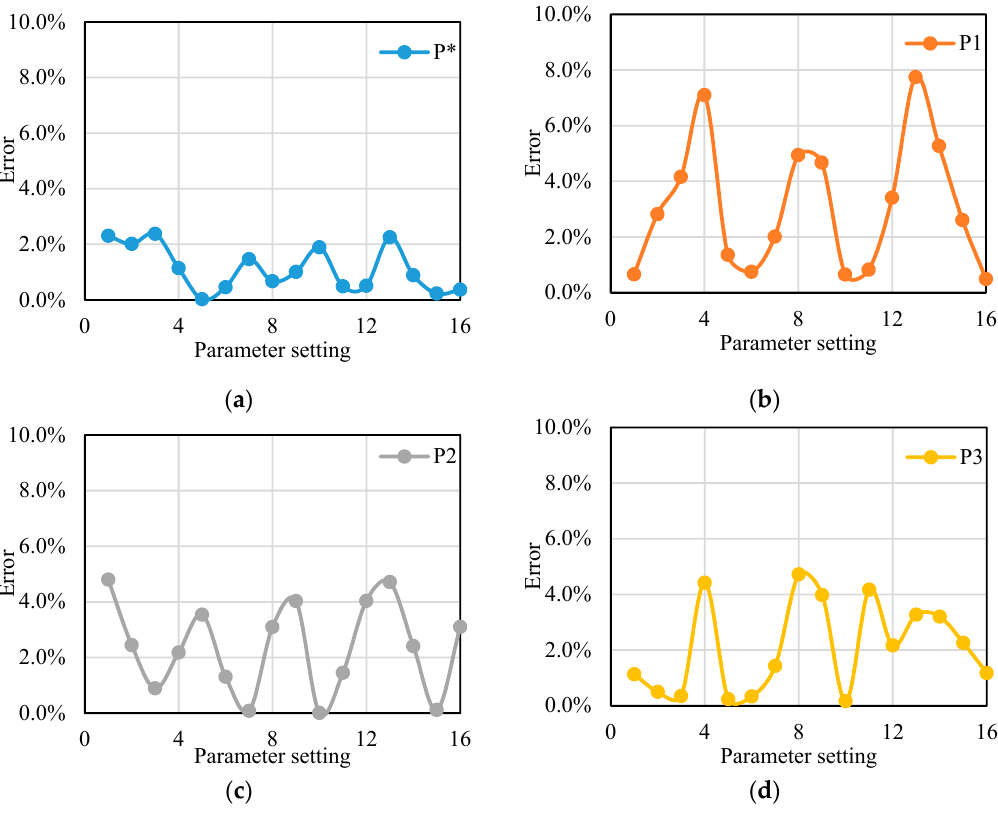
Figure 8. The prediction errors of the four models (Experiment-I): ( a ) proposed model; ( b ) model 1; ( c ) model 2; ( d ) model 3.